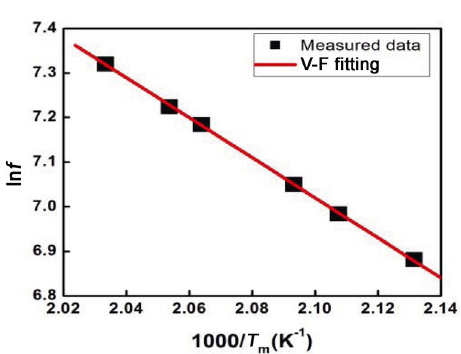
Fig. 3 Variation of (b) 200, and (c) 300 kHz.